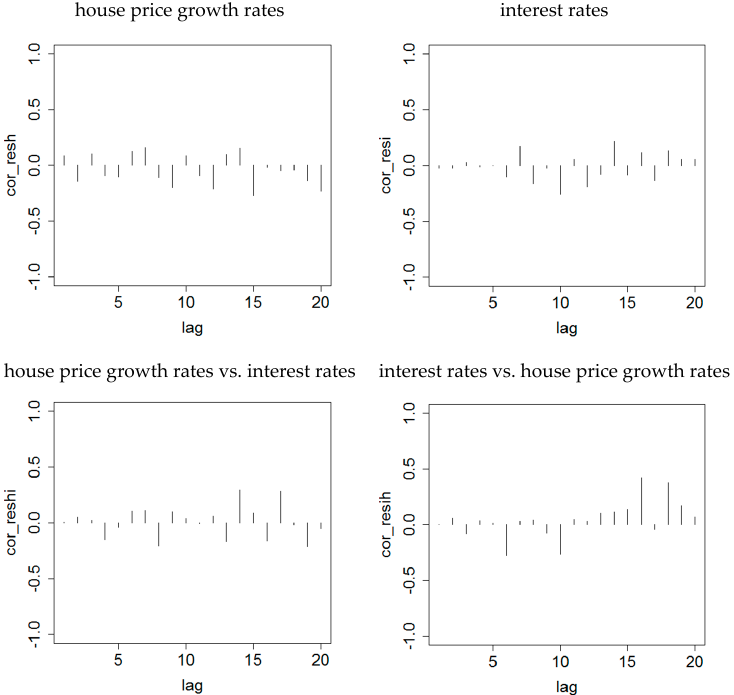
Figure 5. Sample autocorrelations and cross-correlations of house price growth rates and interest rates. house price growth rates interest rates